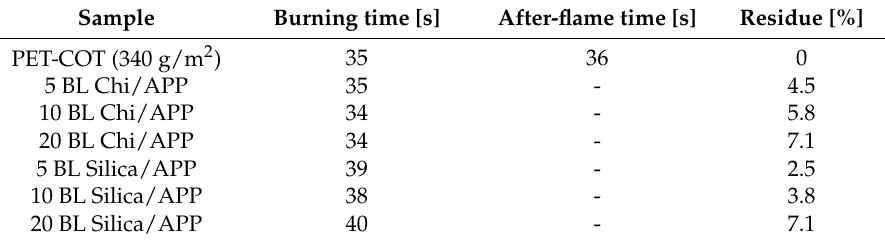
Figure 13. TTI and PHRR values of PET fabrics treated with 10 and 20 BL of Chi/APP or silica/APP Table 16. Combustion data of untreated and BL-treated PET-COT fabrics by vertical flame spread tests [30].